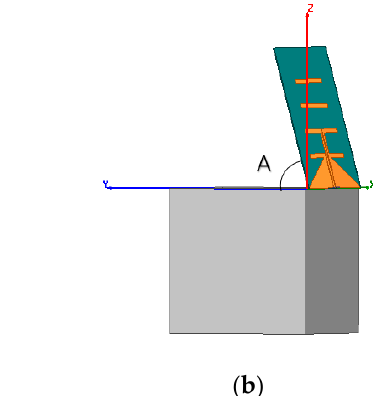
Figure 4. Fabricated antenna on 1U Cube with various lift angle. A high frequency simulator structure (HFSS) [22] is used to simulate the proposed Yagi antenna. The measurements of the reflection coefficients of the fabricated Yagi antenna were conducted by